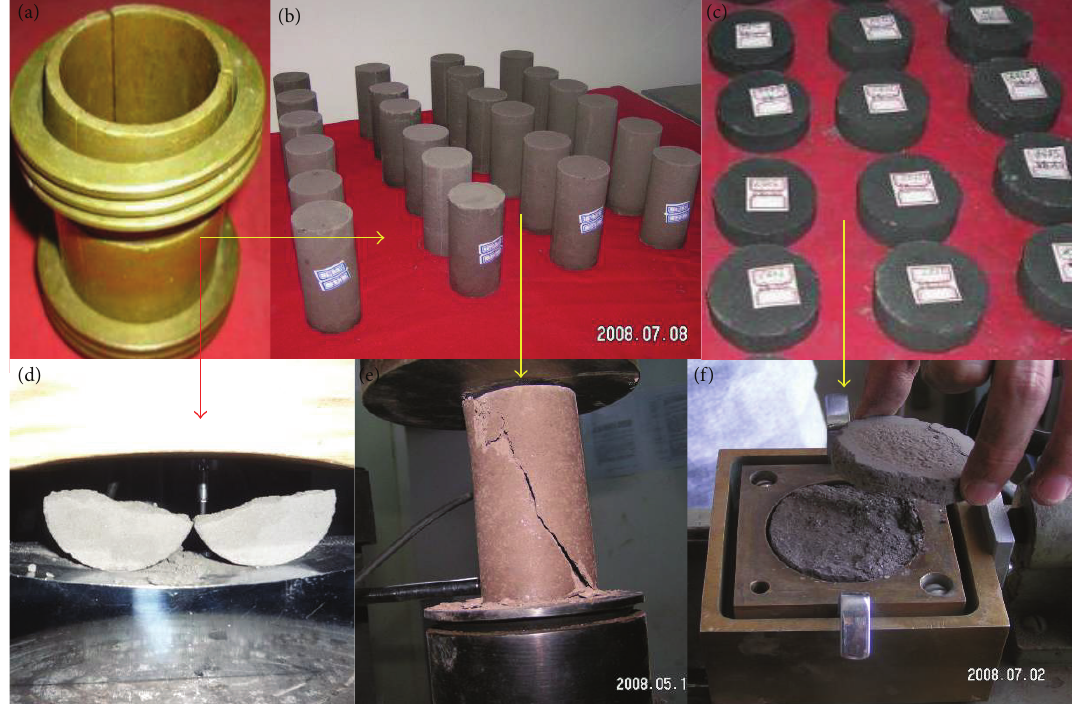
Figure 3: Mechanical test on analogical material. (a) is the specimen mould. (b) is the specimens for UCS. (c) is the specimens for direct shear test. (d) is the Brazilian test. (e) is the uniaxial test. (f) is the direct shear